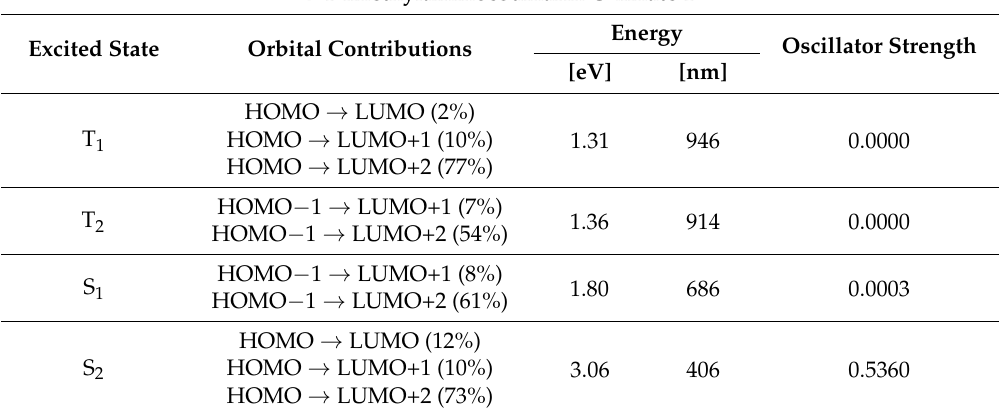
Table 2. Excitation energies, oscillator strengths ( f ) and orbital contributions to corresponding electronic transitions from ground state (S 0 ) of oximate 1 (geometry was optimized at the M06-2X/6-31+G(d,p) level of theory and energies were calculated at the M06-2X/6-311+G(2d,p) level of theory).